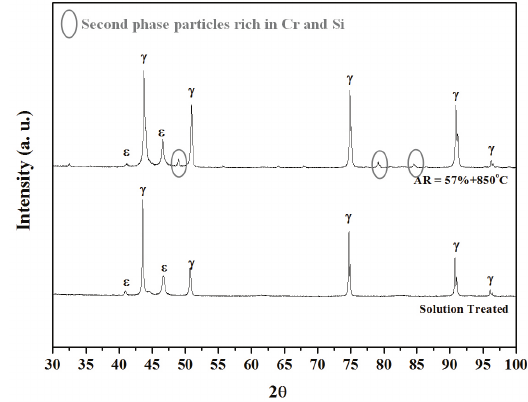
Figure 3. XRD patterns of the stainless shape memory steel in the solution treated and deformed (AR = 57%) and annealed at 850°C for 1 h conditions.